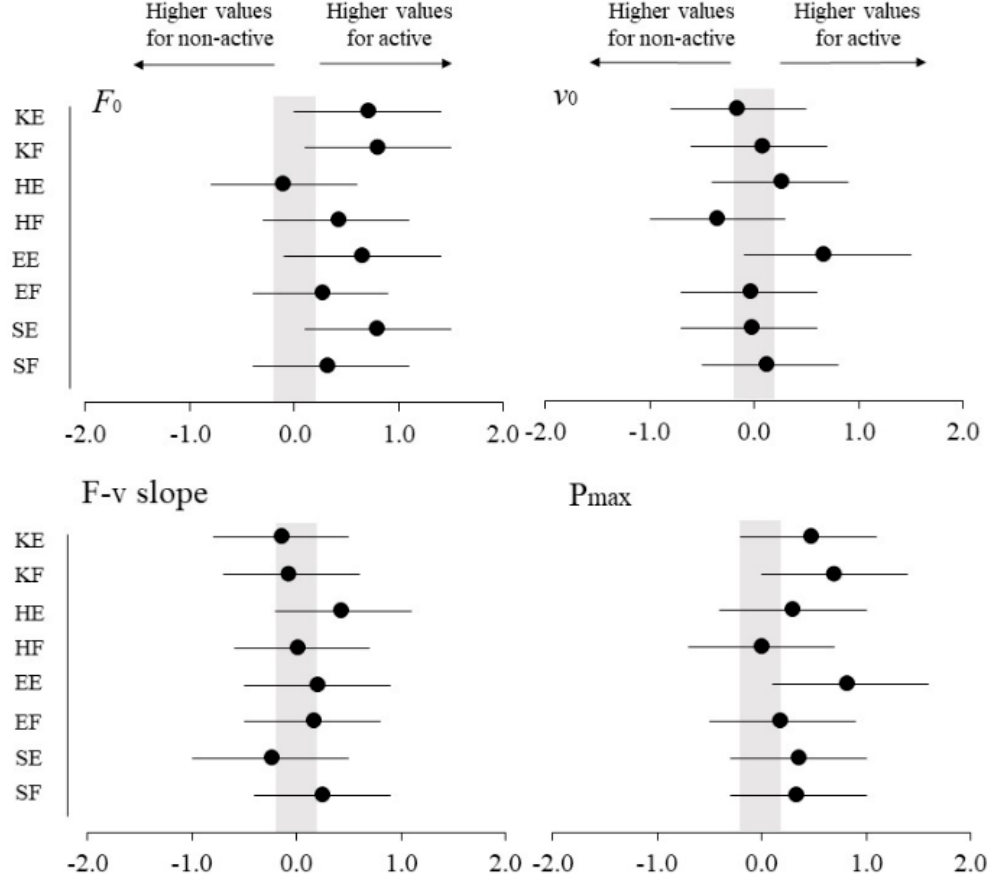
Figure 3. Standardized di ff erences (E ff ect sizes and 95% confidence intervals) for maximum force ( F 0 ; upper-left panel ), maximum velocity ( v 0 ; upper-right panel ), force-velocity slope (F-v slope; lower-left panel ) and maximum power (P max ; lower-right panel ) between active and non-active groups for each muscle group. ES, e ff ect size. KE, knee extension; KF, knee flexion; HE, hip extension; HF, hip flexion; EE, elbow extension; EF, elbow flexion; SE, shoulder extension; SF, shoulder flexion. (E ff ect size = Active mean − Non-active mean / SDboth). The probability that the true di ff erence was trivial (ES from − 0.20 to 0.20) or substantial is depicted.